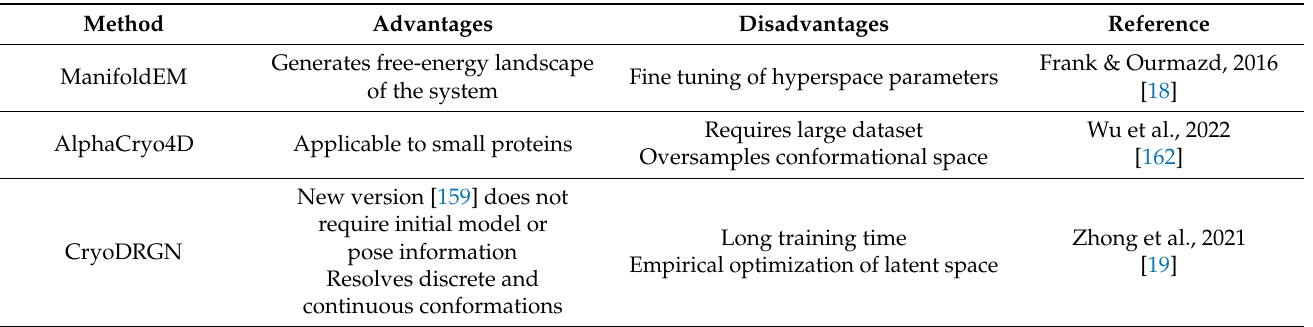
Table 1. Recently developed methods for heterogeneous reconstruction of biomolecular structures displaying continuous conformational